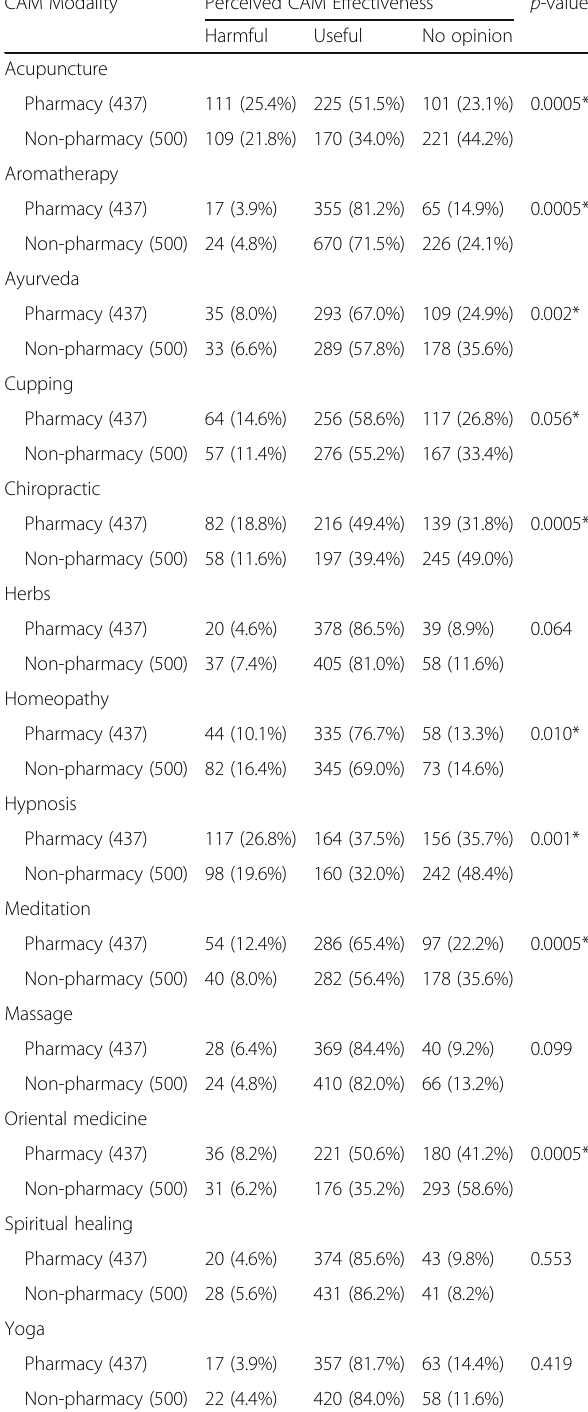
Table 6 Student ’ s Perceived CAM